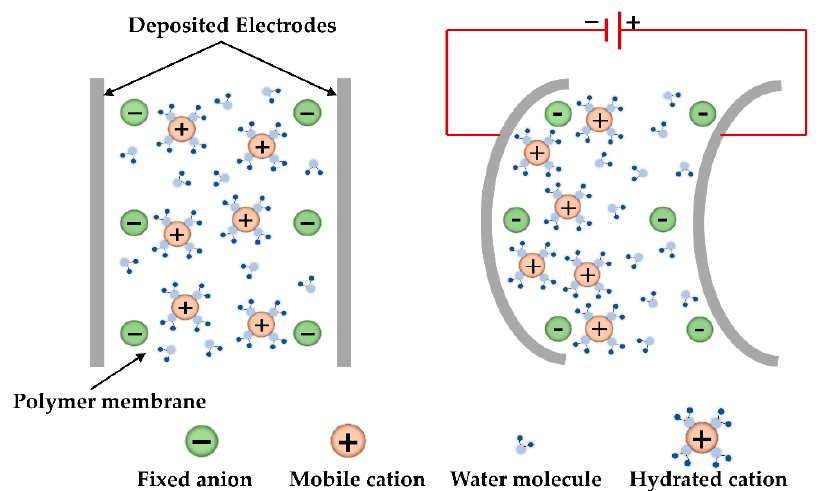
Figure 4. Actuation principle of a typical strip-shaped IPMC.